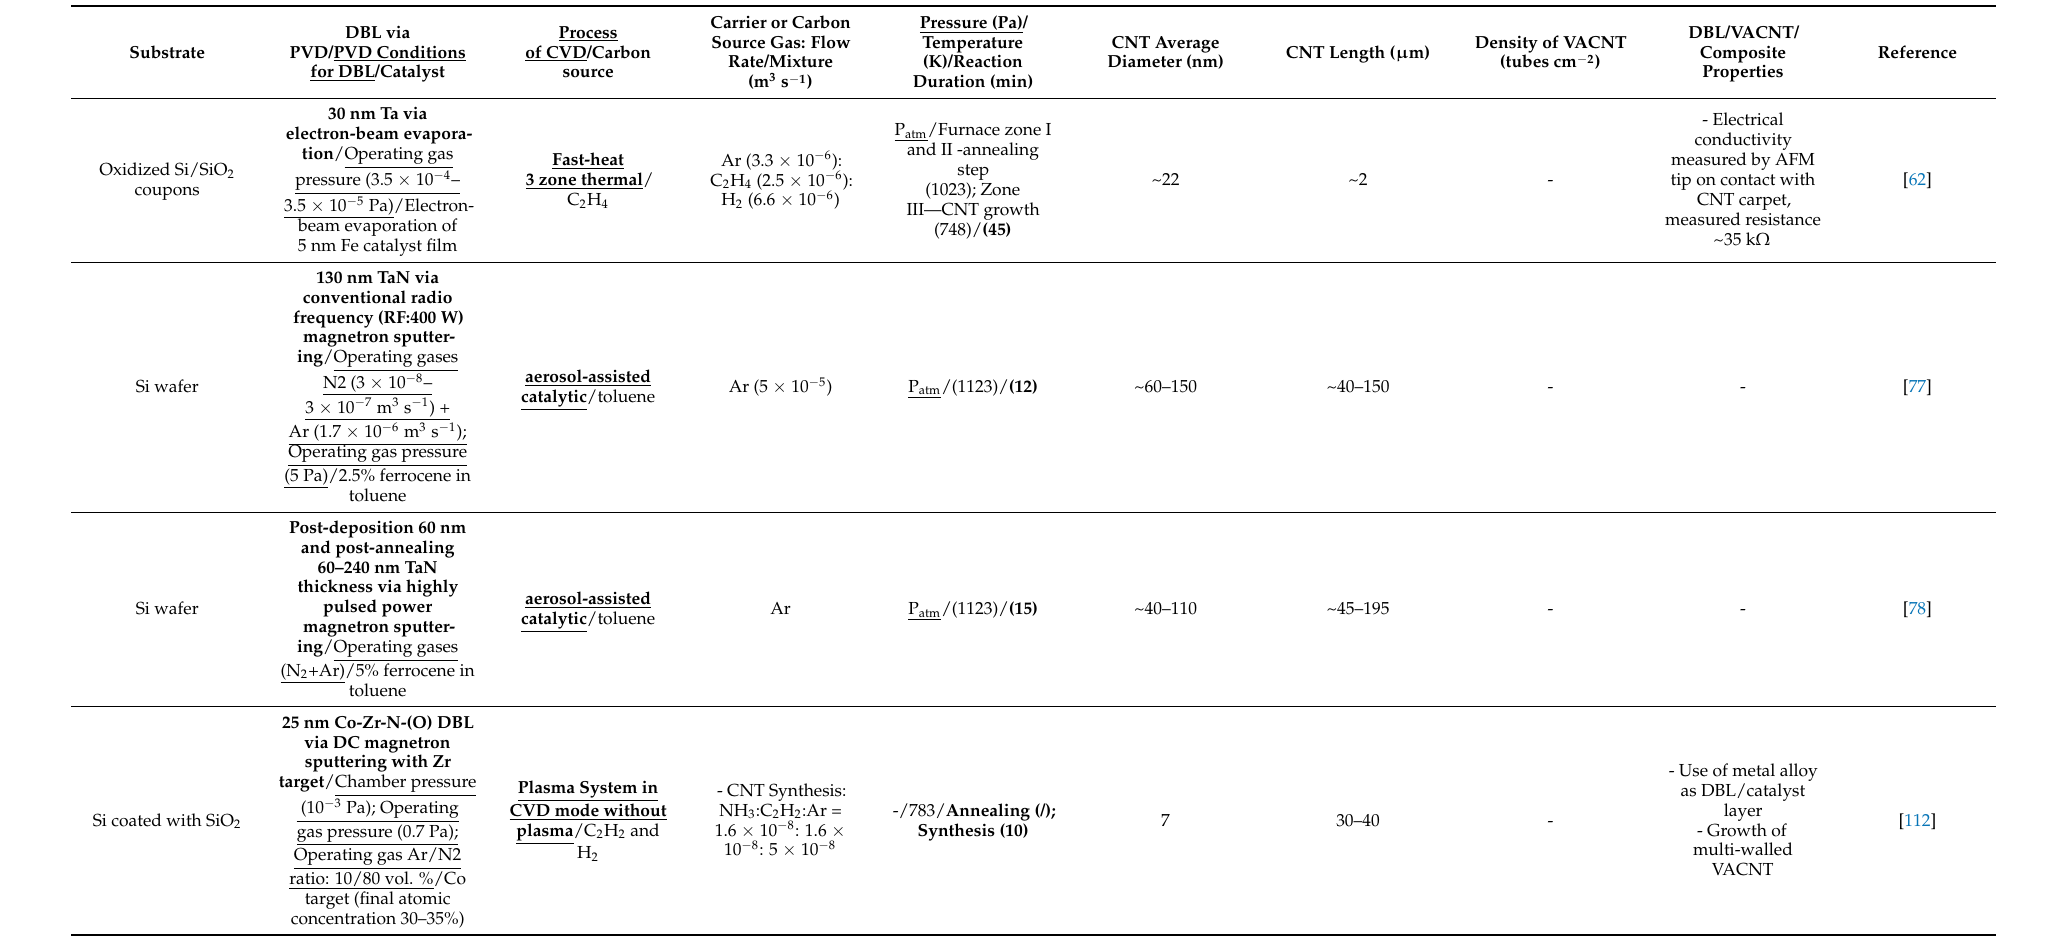
Table 3. Details of used substrate, metal or metal nitrides DBL without the use of Al top-layer (deposited via PVD), and VACNT growth conditions and